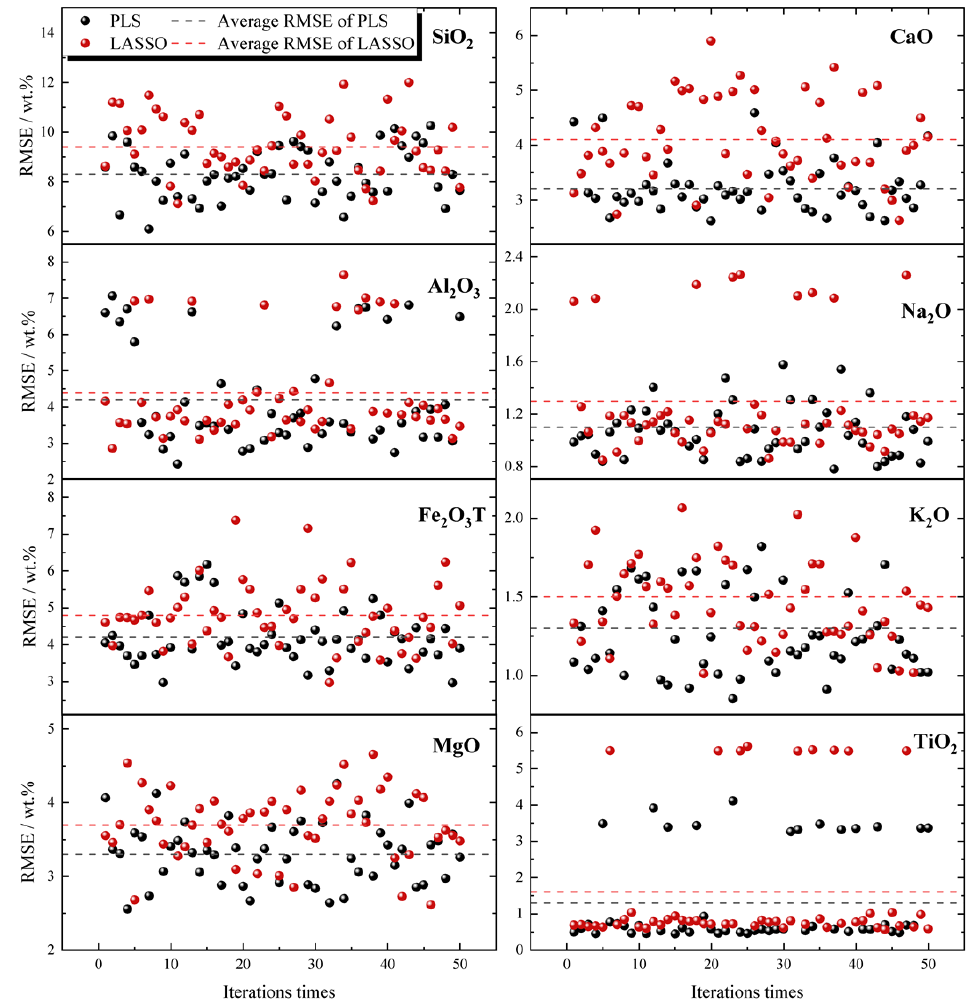
Figure 6. RMSEs of test sets in 50 PLS and 50 LASSO models. Dash lines indicate the average RMSE of 50 RLS models (black line) and 50 LASSO models (red line).